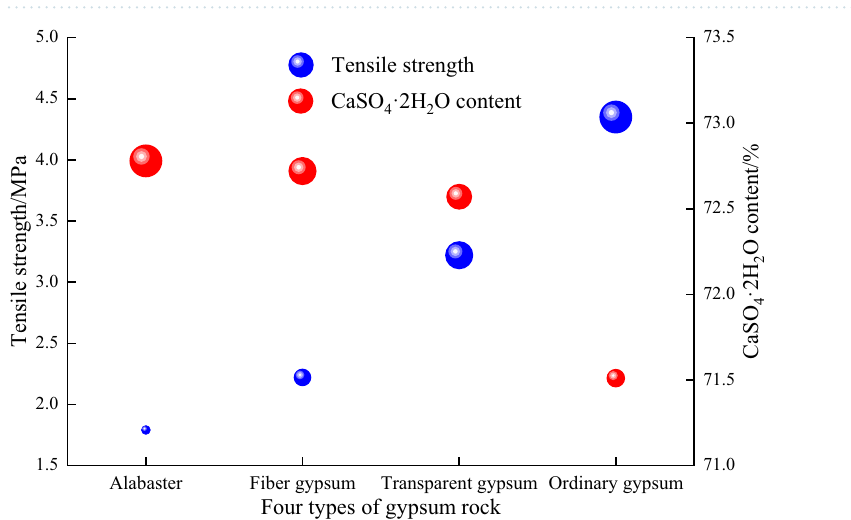
Figure 9. The relationship between CaSO 4 ·2H 2 O content and tensile strength of gypsum rocks. The size of the ball is consistent with the value of tensile strength and the content of CaSO 4 ·2H 2